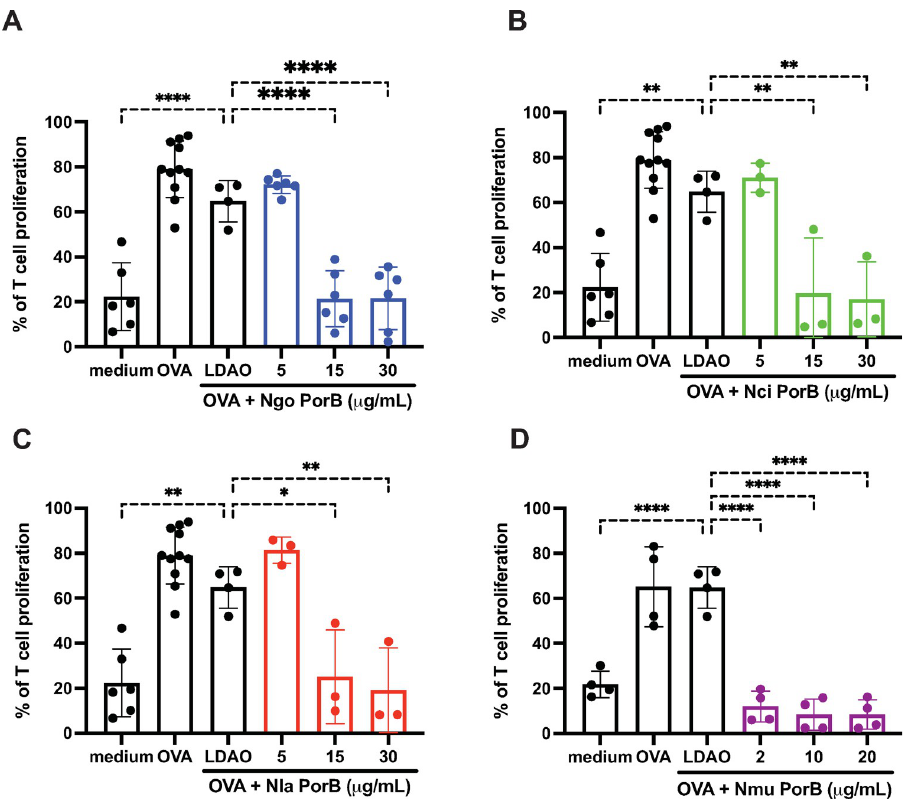
Fig 7. Purified recombinant PorB inhibits OVA-pulsed dendritic cell-induced T cell proliferation. DCs were exposed to OVA with LDAO-containing buffer (vehicle) or PorB proteins from the indicated species (A, Ngo ; B, Nla ; C, Nci ; and D, Nmu ) at three different concentrations. The DCs were subsequently incubated with CFSE-labeled OT-II T cells and T cell proliferation was assessed after seven days by flow cytometry as described in Materials and Methods. Bar graphs show combined results of T cell proliferation assays assessed in three independent experiments with the indicated dose of each PorB. Statistical significance was determined by one-way ANOVA with Dunnett analysis for multiple comparisons against the vehicle control ( * , P < 0.05; ** , P < 0.01; *** , P < 0.001; and **** , P < 0.0001). LDAO, Lauryldimethylamine